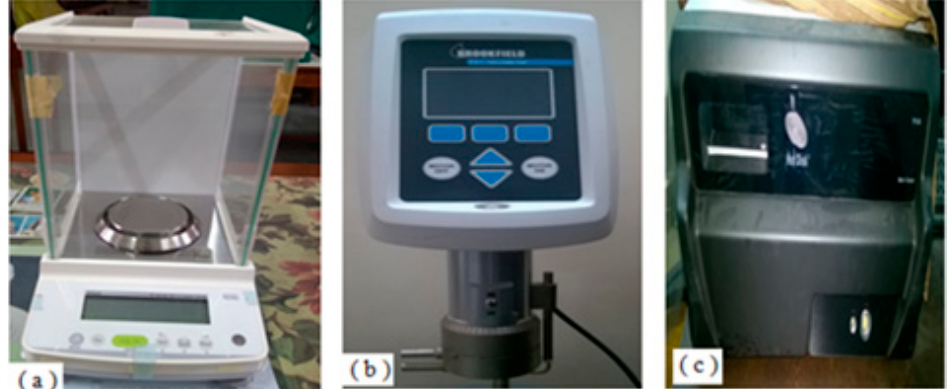
Figure 4. Photographs of ( a ) digital weighing balance, ( b ) Brookfield DV1 digital viscometer, and ( c ) hot disc thermal constant analyzer apparatus [48].